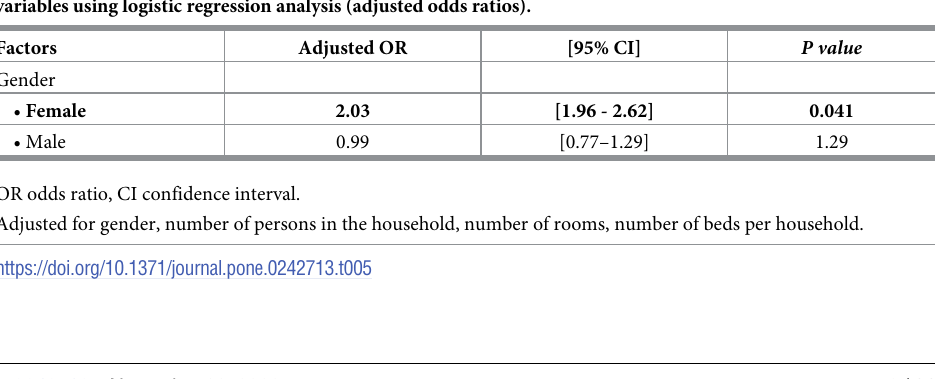
Table 5. Relationship between Plasmodium spp infection and gender, adjusted for the other sociodemographic variables using logistic regression analysis (adjusted odds ratios). Factors